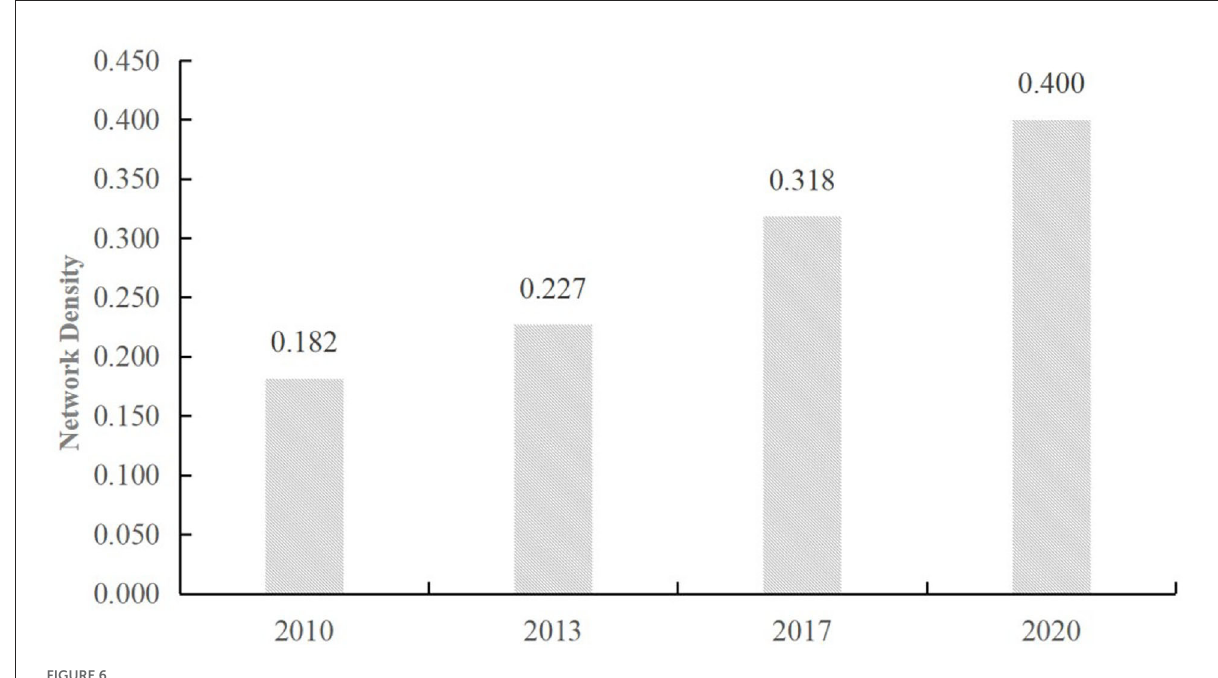
FIGURE6 Analysis of network density in the